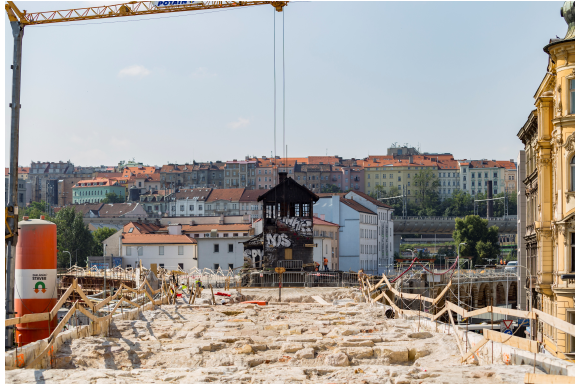
Figure 2. View of the exposed sandstone arches of the